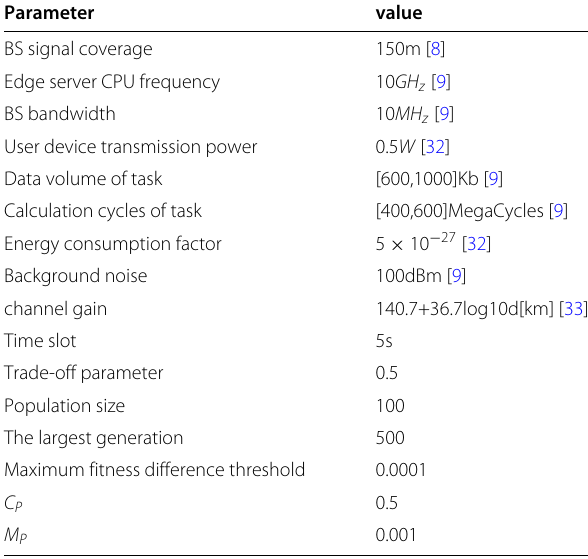
best latency performance, PROMOT places in the mid- dle, while AOS performs the worst. This because when all users offload the task in AOS, they will interfere with each other and occupy limited channel resources. This will inevitably lead to a decrease in data transmission rate, thus Table 2 Simulation